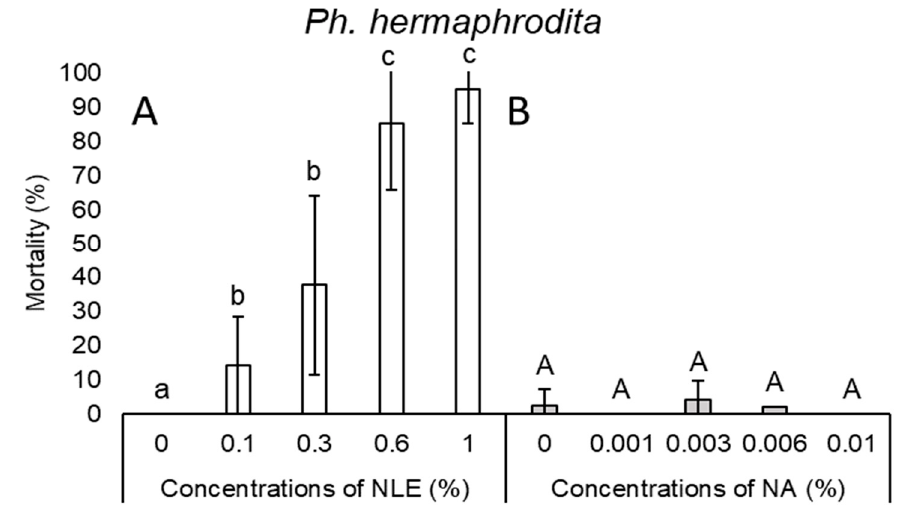
Figure 2. Mortality after 24-h exposure time of Phasmarhabditis hermaphrodita juveniles of 0.1%, 0.3%, 0.6%, and 1% NLE ( A ) and 0.001%, 0.003%, 0.006%, and 0.01% of NA ( B ). (One-way ANOVA, Mann–Whitney U test; the same letters indicate no significant difference at p < 0.05 level).